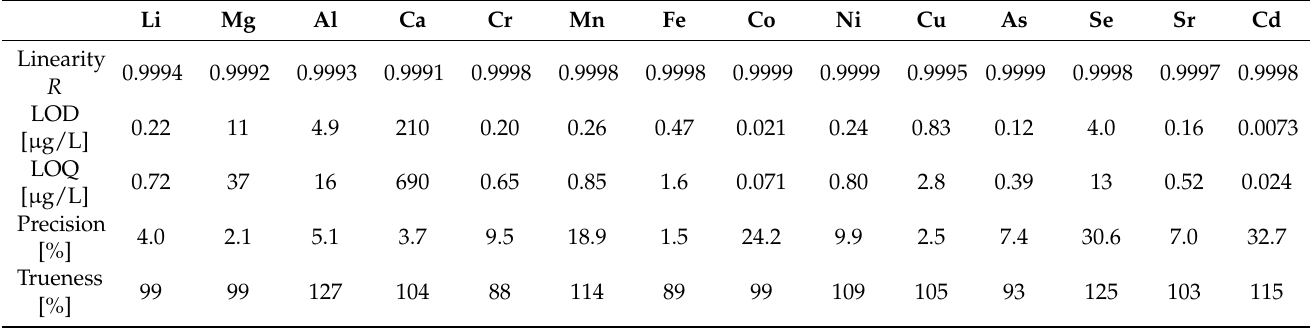
Table 2. Results of the validation of element analysis—parameters of the analytical